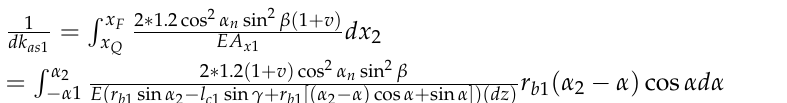
Figure 5 is the mesh stiffness of cracked gear pair when the axial force is neglected and considered, respectively. The stiffness reduced 0.7 × 10 8 N/m after the axial force is considered in the method. It is shown that the stiffness decreased by 25%. This is because the axial bending and the axial shear stiffness reduces when a crack fault happens.